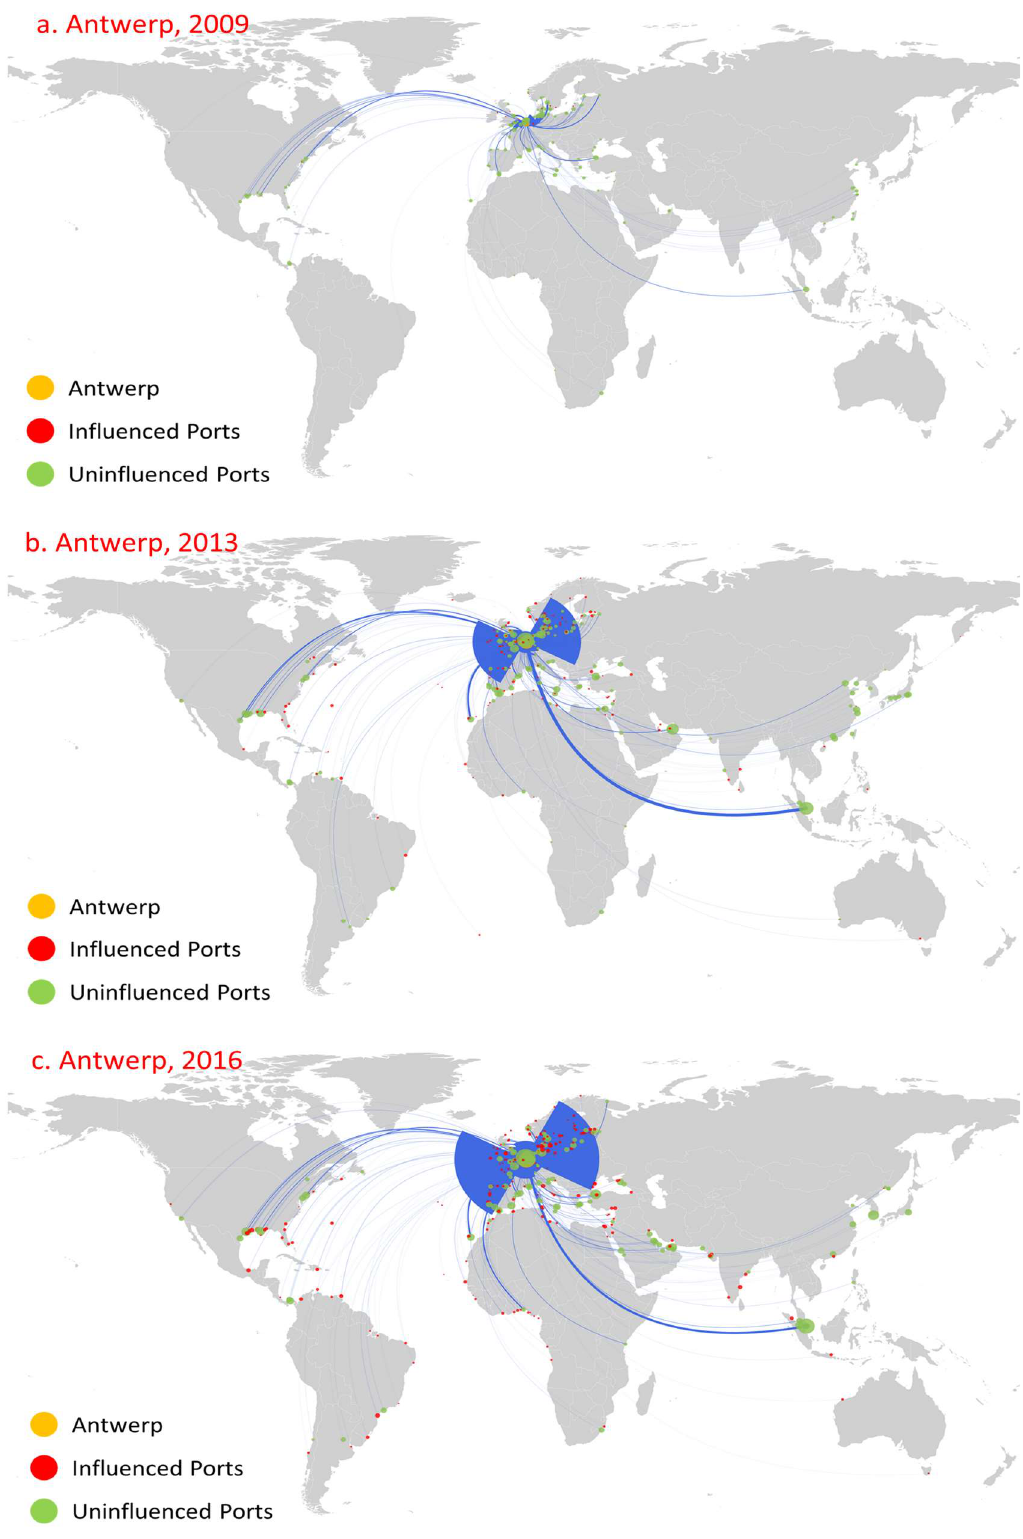
Figure 5. Influence diffusion at the first stage: